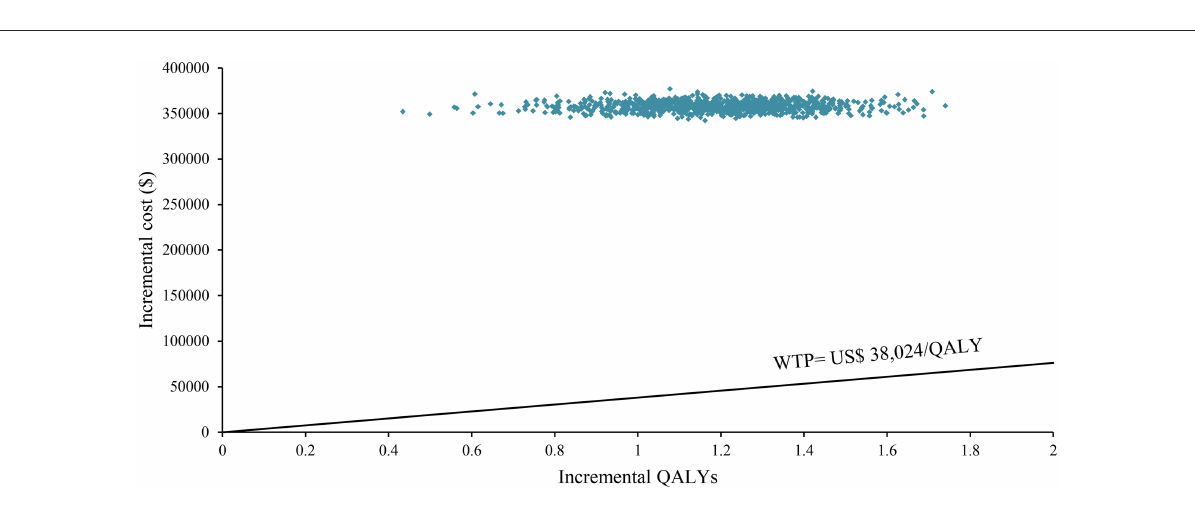
FIGURE4 The scatter diagram in the partitioned survival